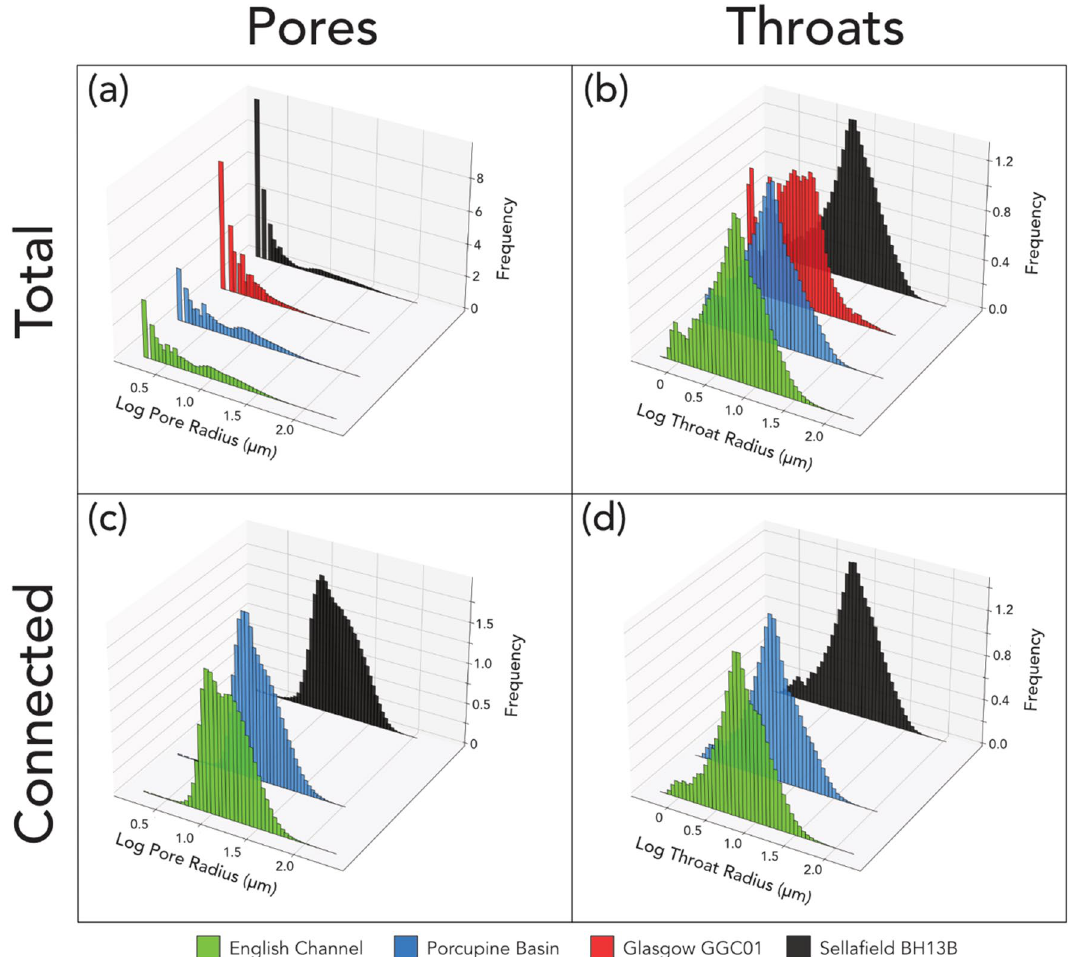
Figure 5. 3D histograms showing the size distributions of pore and throat radius across all sample suites for both total and connected porosity. ( a ) Shows a large proportion of small pores with a secondary minor peak of larger pores, identified clearly in ( c ) where only connected porosity is considered. Observation of the connected pores alone shows that the smallest pores do not contribute to connectivity. ( b ) Shows a more normal distribution of the throat radii with a minor peak representing smaller throats. This minor peak is lost when observing only the connected throats ( d ) whilst the larger throats remain. Both the trends shown by pores and throats are similar in nature however, is far more dramatic in the case of the